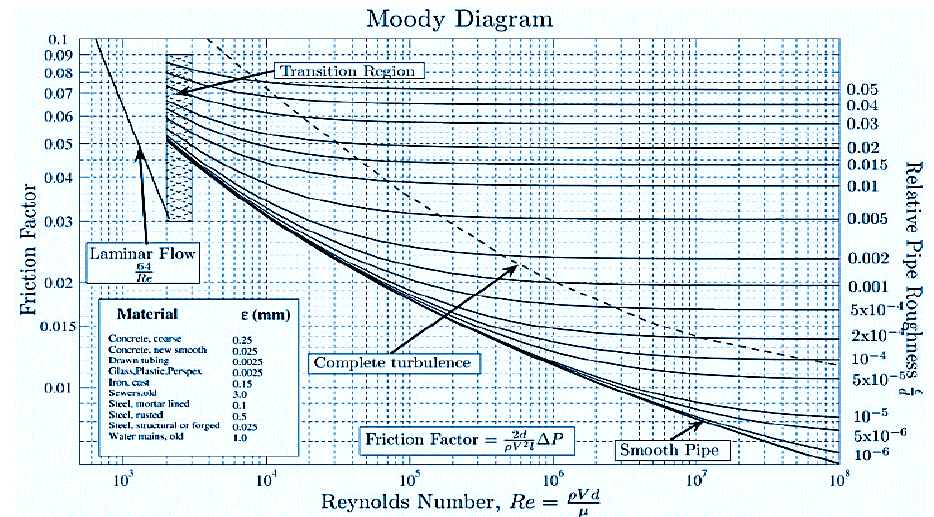
Figure 7. Moody diagram showing friction factor and relative pipe roughness for different flow regimes [48].